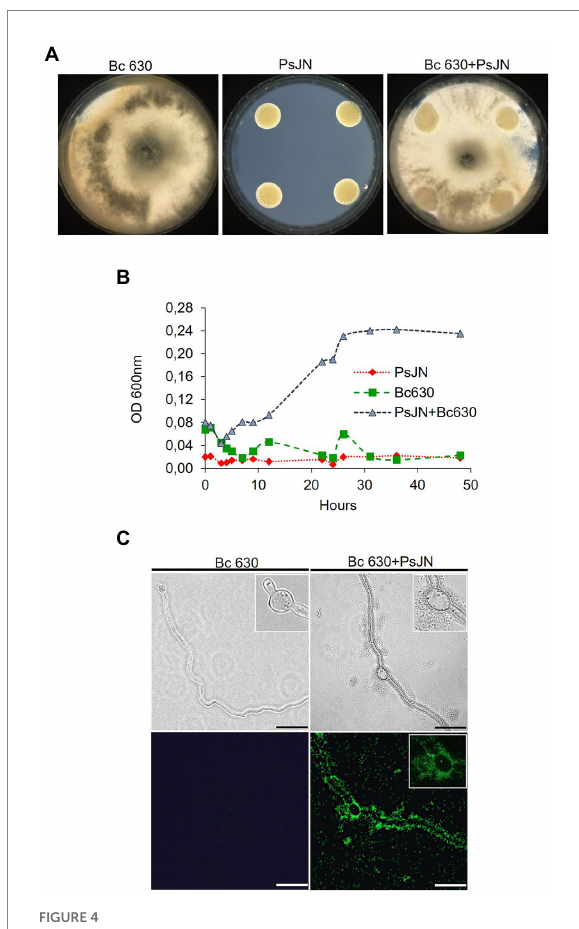
FIGURE 4 Co-culture of P. phytofirmans PsJN and B. cinerea . (A) Mycelial growth of B. cinerea with PsJN- gfp or not on PDA solid medium (in standard 90 mm Petri dishes). (B) Growth curves of PsJN and B. cinerea cultivated separately or both in minimal liquid medium. (C) Observations of B. cinerea mycelium 24 hpi with PsJN- gfp or not in liquid minimal medium, under fluorescence microscope. Scale bars = 100 μ